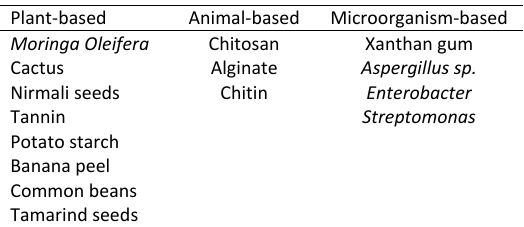
Table 2: Types of natural coagulants